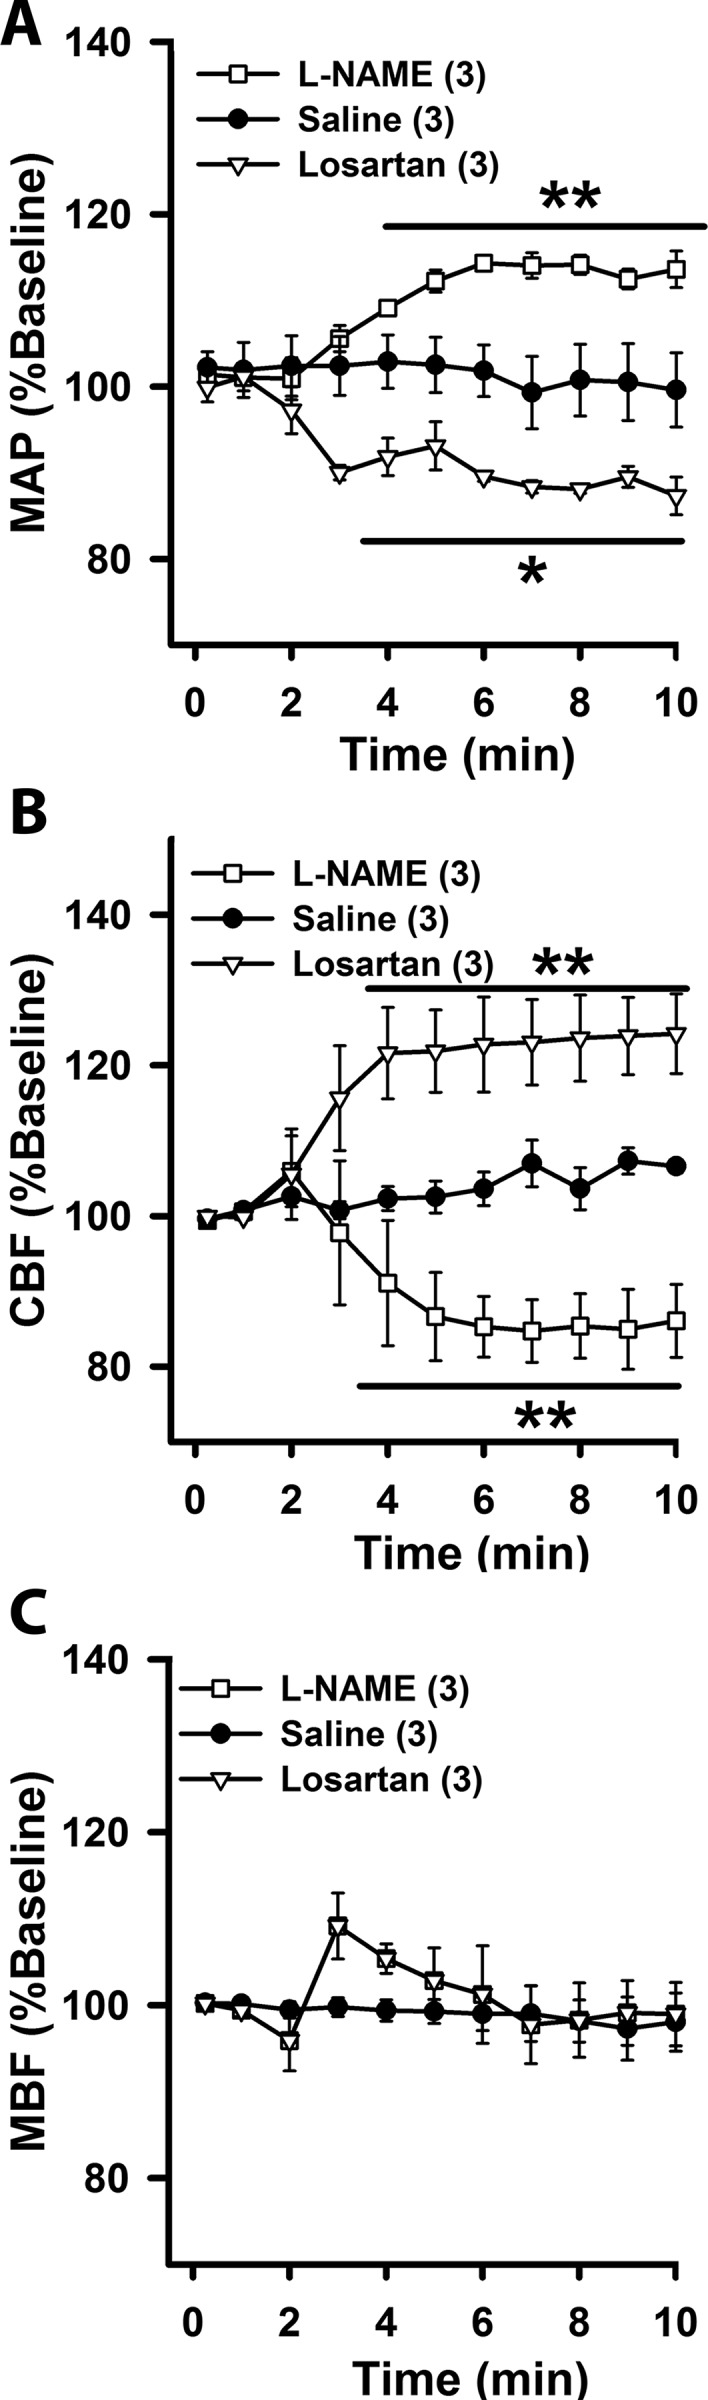
The effects of acute intravenous administration of 10 L of saline (n = 3), 30 mg/kg l-NAME (n = 3), and 20 mg/kg losartan (n = 3) on MAP (A), renal CBF (B), and renal MBF (C). Data are expressed as percentage changes from baseline values determined as the mean values over 2 minutes before drug or vehicle administration. All values are mean ± SEM. *P < .05 and **P < .01 versus saline.